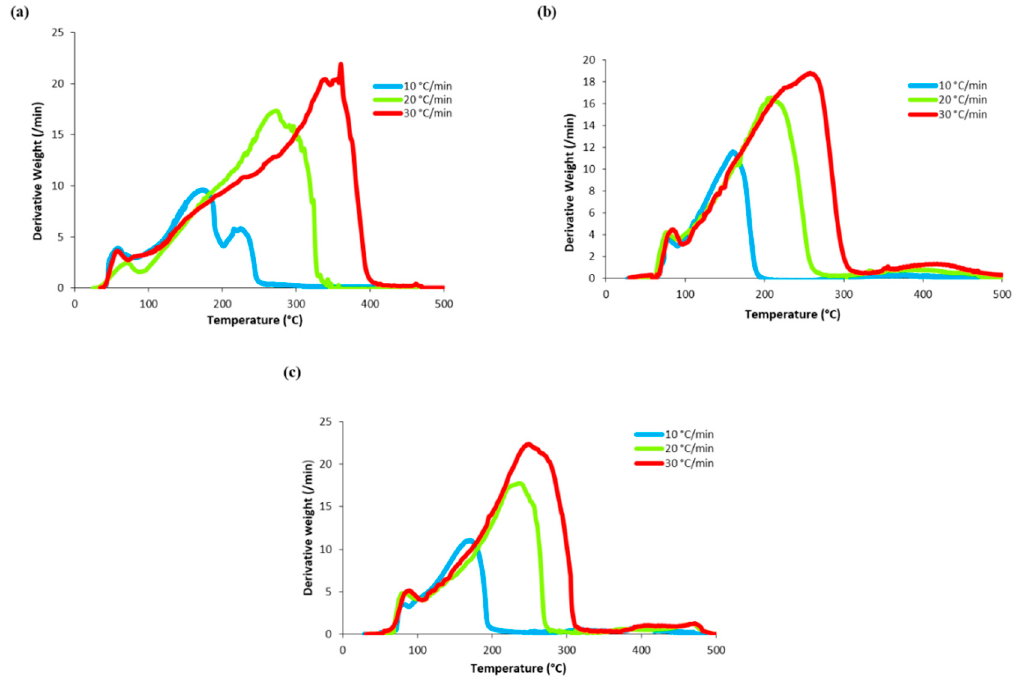
Figure 2. Derivative Thermogram (DTG) of ( a ) Caulerpa lentillifera , ( b ) Gracilaria coronopifolia and ( c ) Chaetomorpha linum at three heating rates (10 °C/min, 20 °C/min and 30 °C/min).